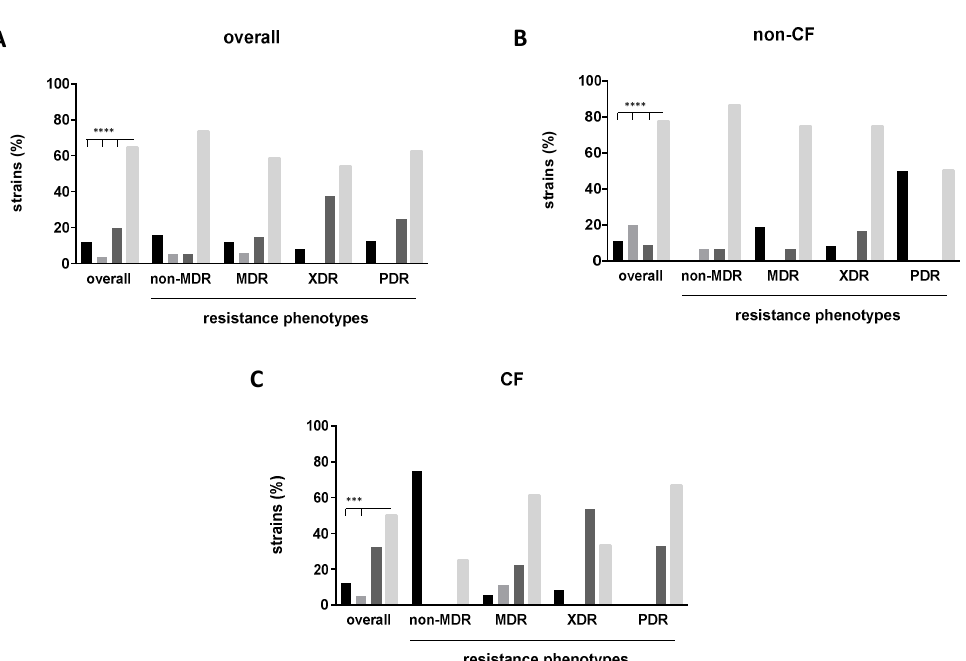
Figure 3. Biofilm formation and multidrug-resistant phenotypes. Biofilm formation was assessed by spectrophotometric assay after crystal violet assay and categorized according to Stepanovic et al. [23]: non-producers, weak-producers, moderate-producers, and strong-producers (left-to-right, in each series of histograms). Susceptibility tests were performed using Kirby-Bauer disk diffusion agar. Resistance profiles according to Magiorakos et al. [24]: MDR, multidrug-resistant strains; XDR, extensively drug-resistant strains; PDR, pandrug-resistant strains. Significance level at Fisher’s exact test: *** p < 0.001; **** p < 0.0001.